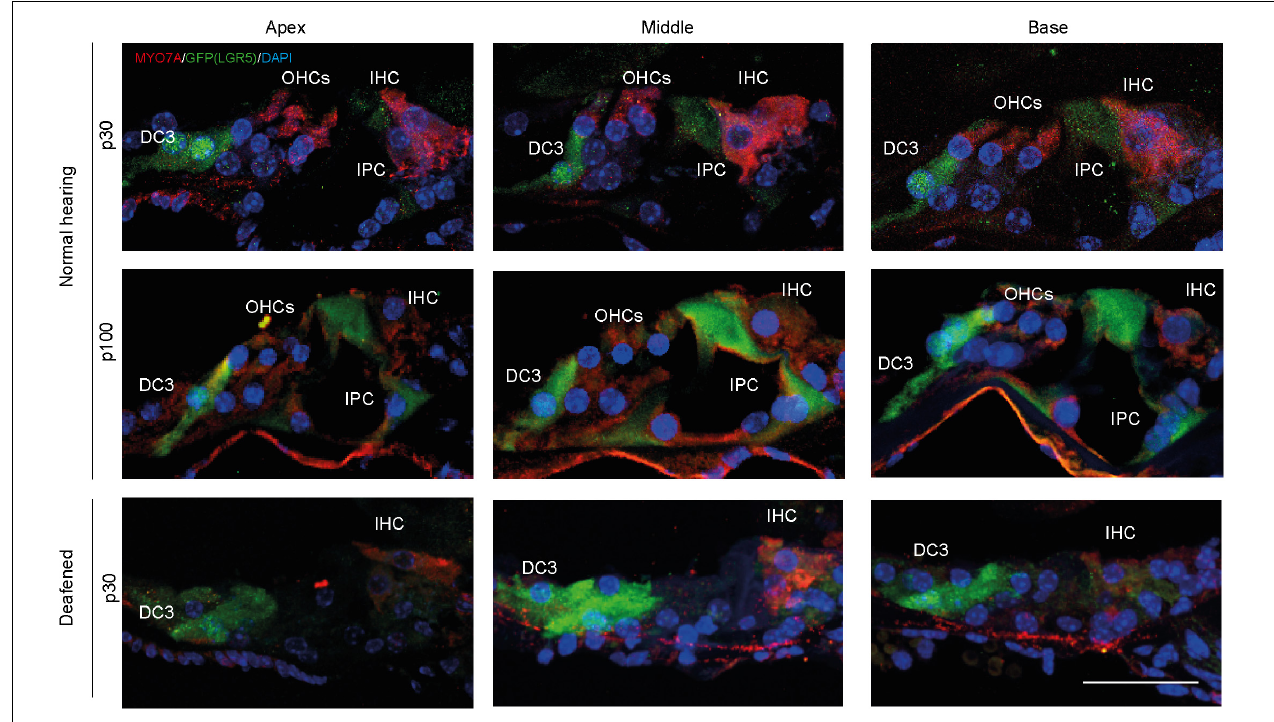
FIGURE 3 | After deafening inner pillar cells (IPCs) lose LGR5 expression. Representative images of immunofluorescence microscopy of cryosections of the cochlea of normal-hearing (p30 and p100) and deafened Lgr5 GFP mice stained with myosin VII A (MYO7A) in red, GFP (LGR5) in green and DAPI in blue. IPCs of normal-hearing animals showed LGR5 expression, which disappeared after deafening. Bar = 10 µ m. n normal hearing ( p30 ) = 6; n normal hearing ( p100 ) = 1 n deafened ( p30 ) = 5 (representative images of 1 cochlea per